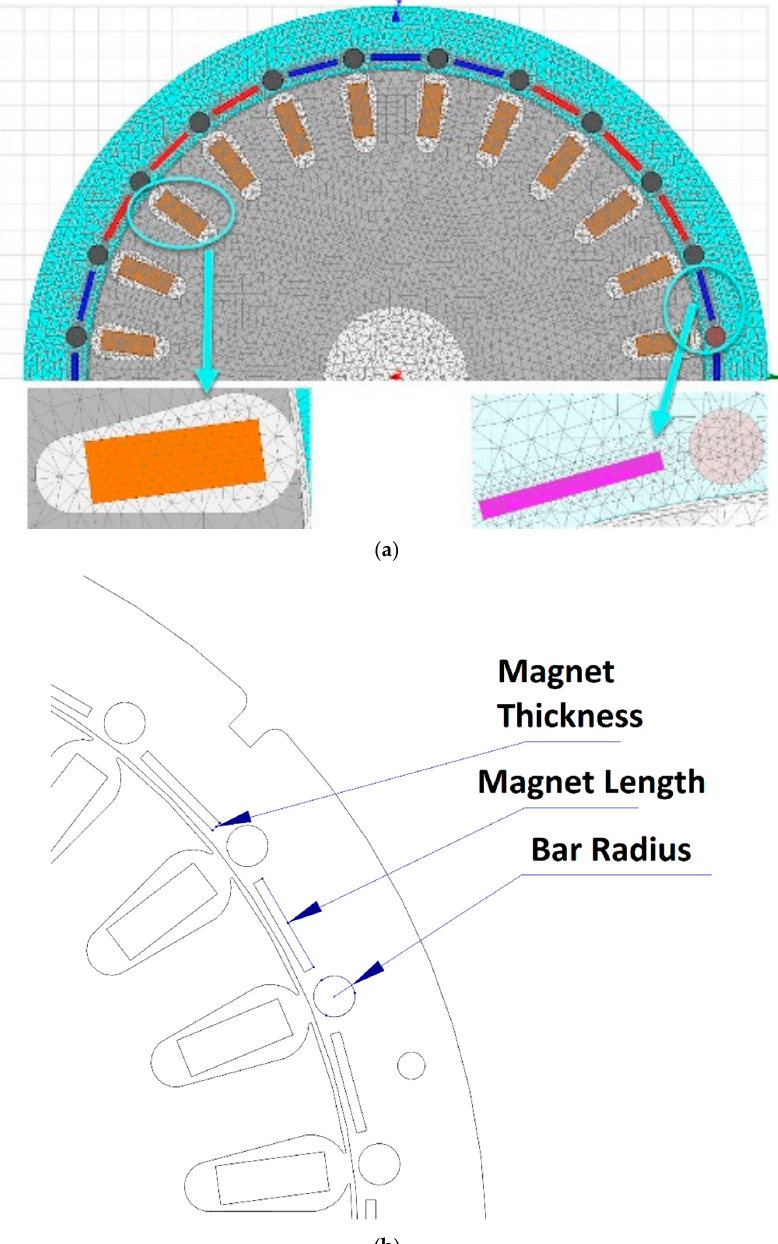
Figure 3. Motor design descriptions, ( a ) 2D mesh model of the Type-D, ( b ) definition of the bar and magnet dimensions.